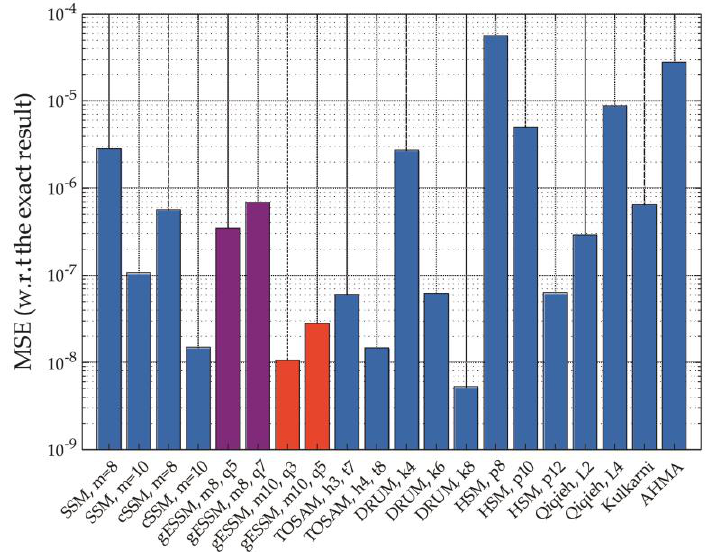
Figure 10. MSE between the approximate and the exact results. The MSE for gESSM m = 8 and m = 10 are highlighted in violet and red, respectively.